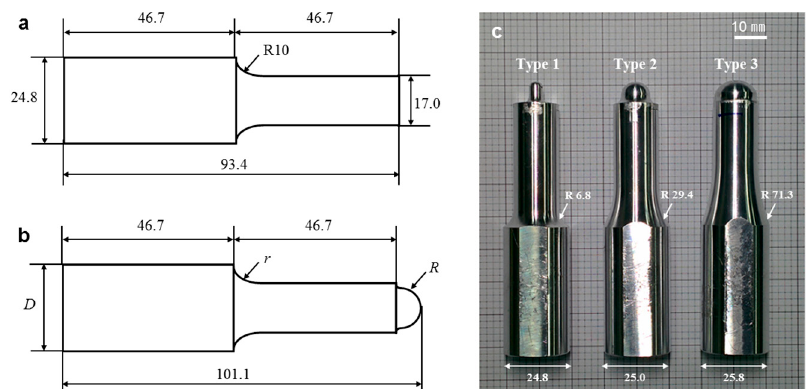
Figure 4. Configuration of the ultrasonic horns: ( a ) flat horn for ultrasonic imprinting; ( b ) curved horn for ultrasonic stretching; ( c ) three design candidates of the curved horn.